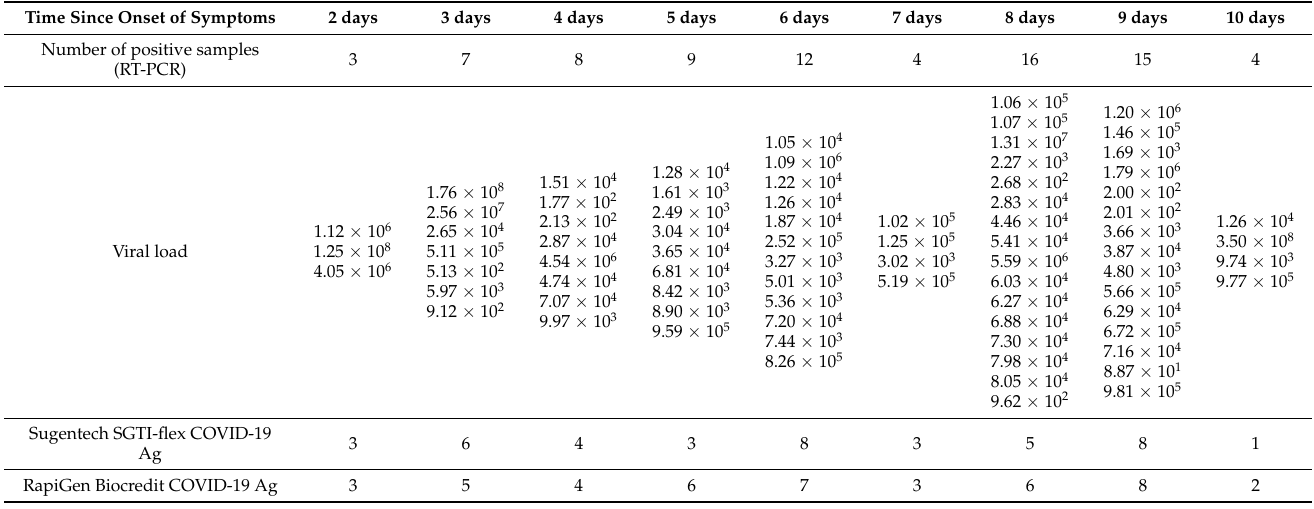
Table A4. Distribution of test results over time from day 2 to day 10 after the onset of